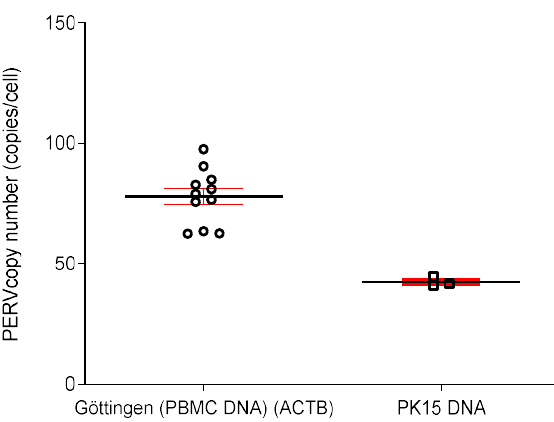
Figure 6. Determination of the PERV copy number in PBMCs from GöMP from Göttingen and in PK15 cells using ACTB as reference.